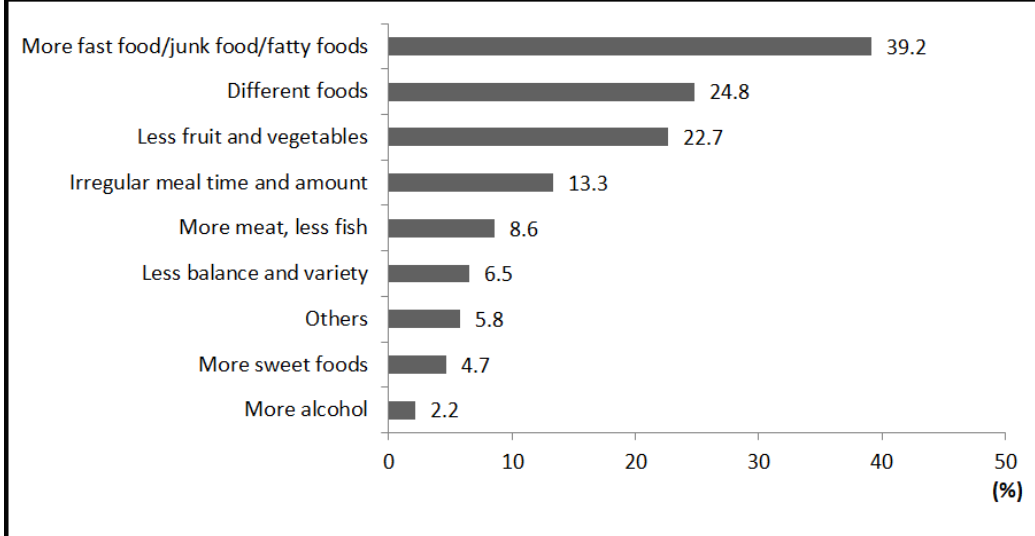
Figure 3. Nine groups of main dietary changes among international students in Ireland ( n = 278).